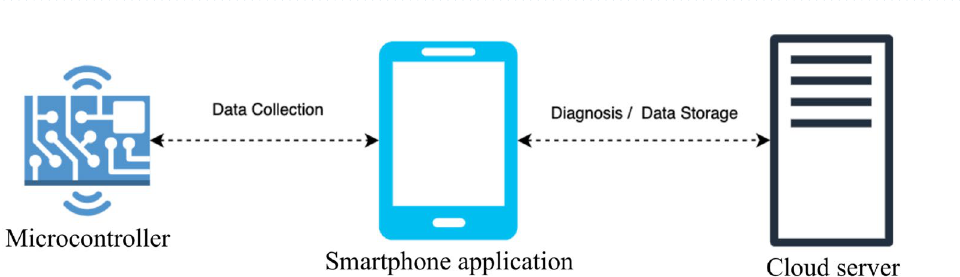
Figure 9. ( A ) First prototype: Main electronic components that integrate the first eNose prototype. The 4 gas sensors sniff the sample and send a VOC-dependent 0–5 V signal to the Arduinos analogic pins. Their combined signal is then reduced in dimensionality and undergoes sample classification. Depending on the prediction, output digital pins supply current to the corresponding LED, alerting of “possibly BC” “prediction no strong enough”(Blank) or “possibly control”(CTR). ( B ) Final prototype: Structure of the device and software application that we mentioned above. The 3D-printed structure contains all parts involved in the urine analysis. The software application is the interface to trigger the analysis and receive the results.